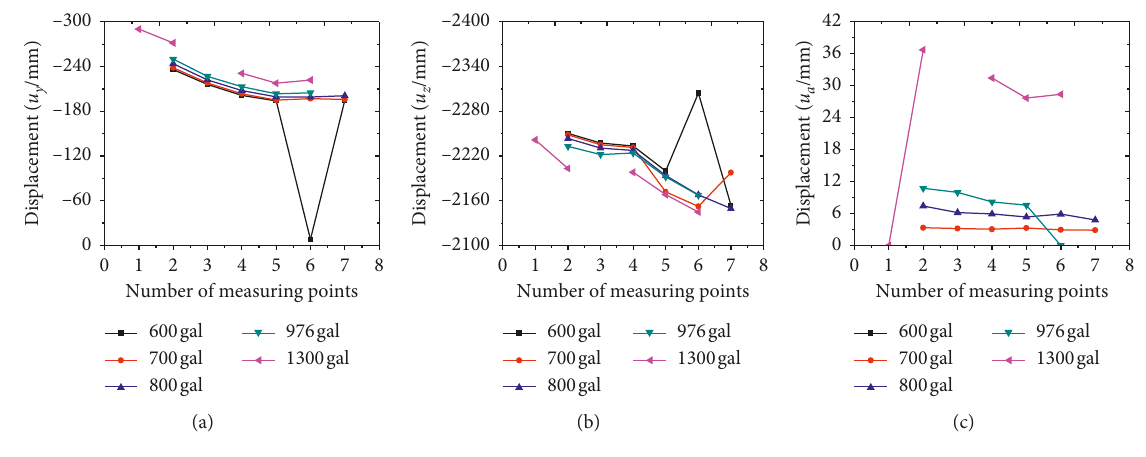
Figure 17: Variation of displacement with